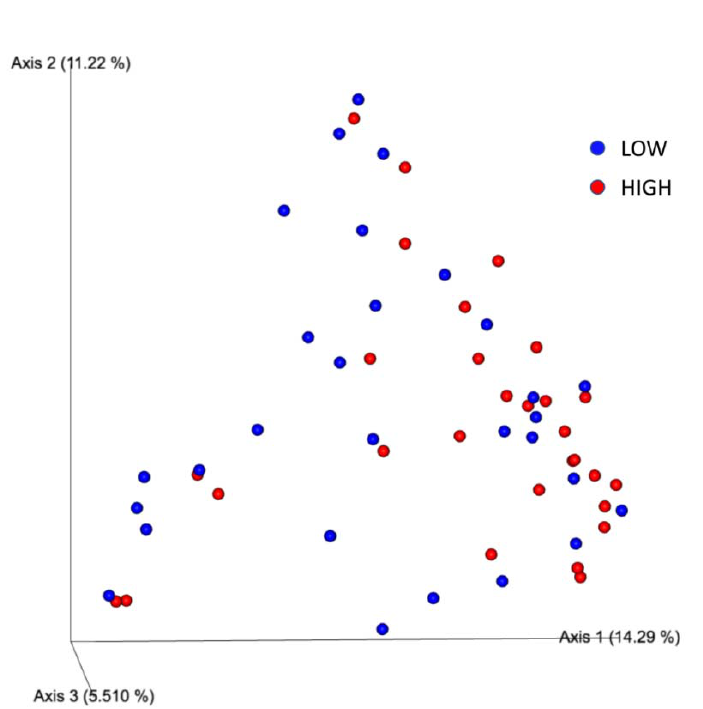
Figure 2. Principal coordinate analysis (PCoA) plot based on unweighted (qualitative) phylogenetic UniFrac distance matrices of water samples according to high or low